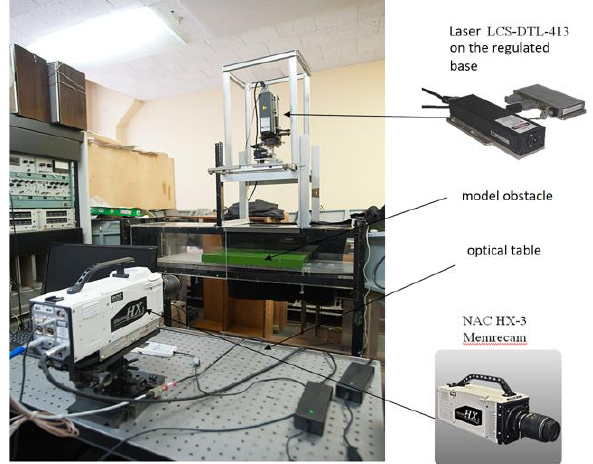
Fig. 2. General scheme of the working part of the wind tunnel with the obstacle (green) and equipment installed for carrying out